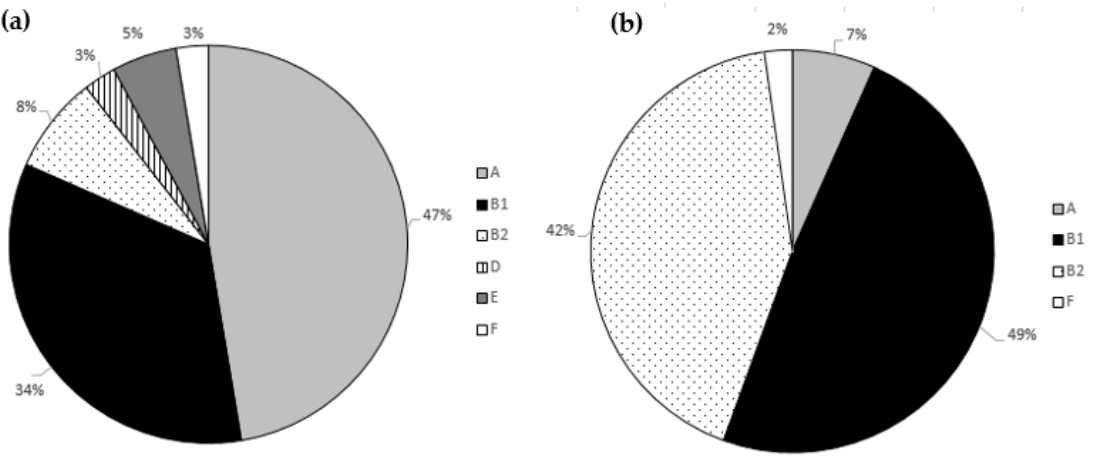
Figure 2. The E. coli phylogroup analysis in ( a ) healthy dogs and ( b ) dogs with diarrhea. The many strains from the dogs with diarrhea were classified into B2 (19/45;